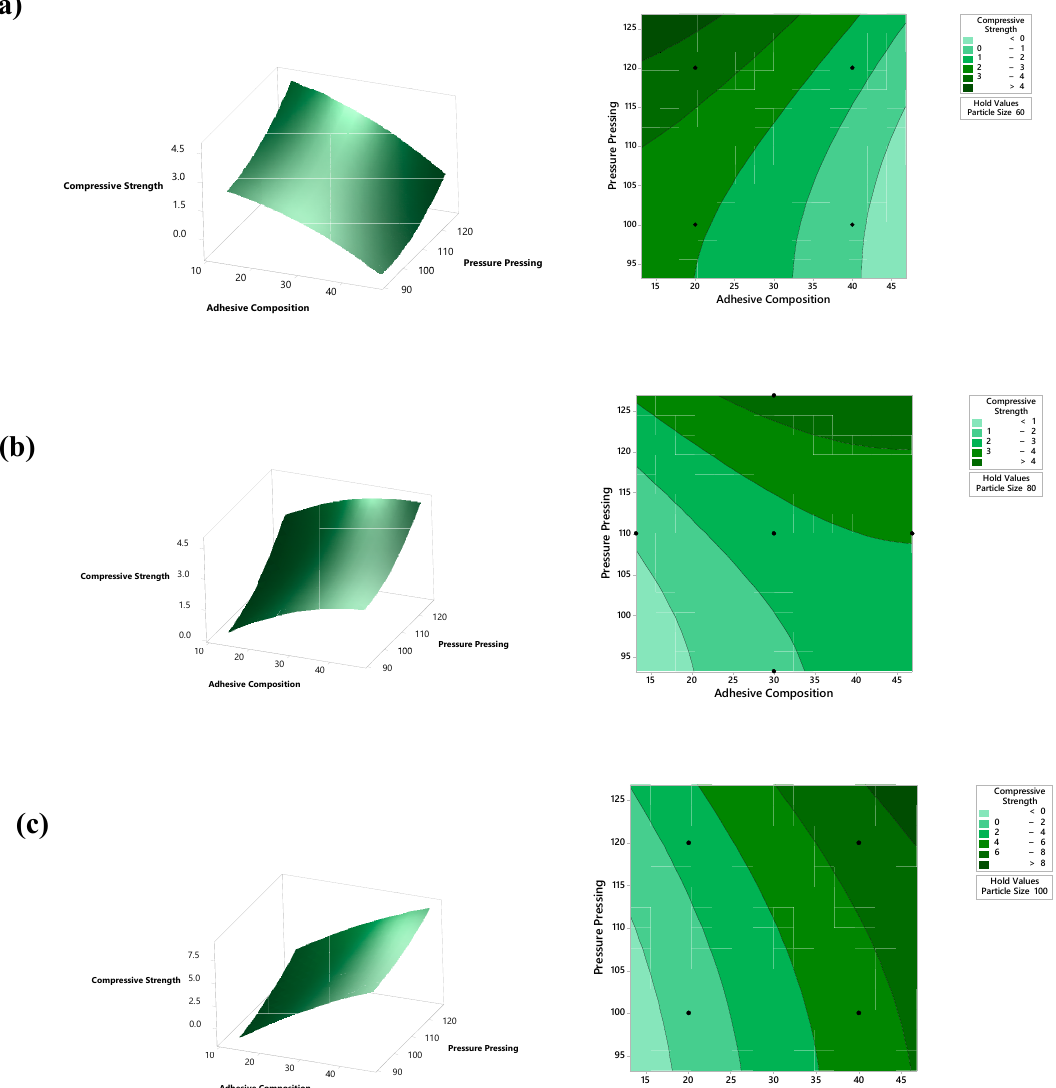
Figure 10. Graph and contour of the surface response of the effect of the adhesive composition and pressing pressure on compressive strength on particle size ( a ) 60 ( b ) 80, and ( c ) 100 mesh.